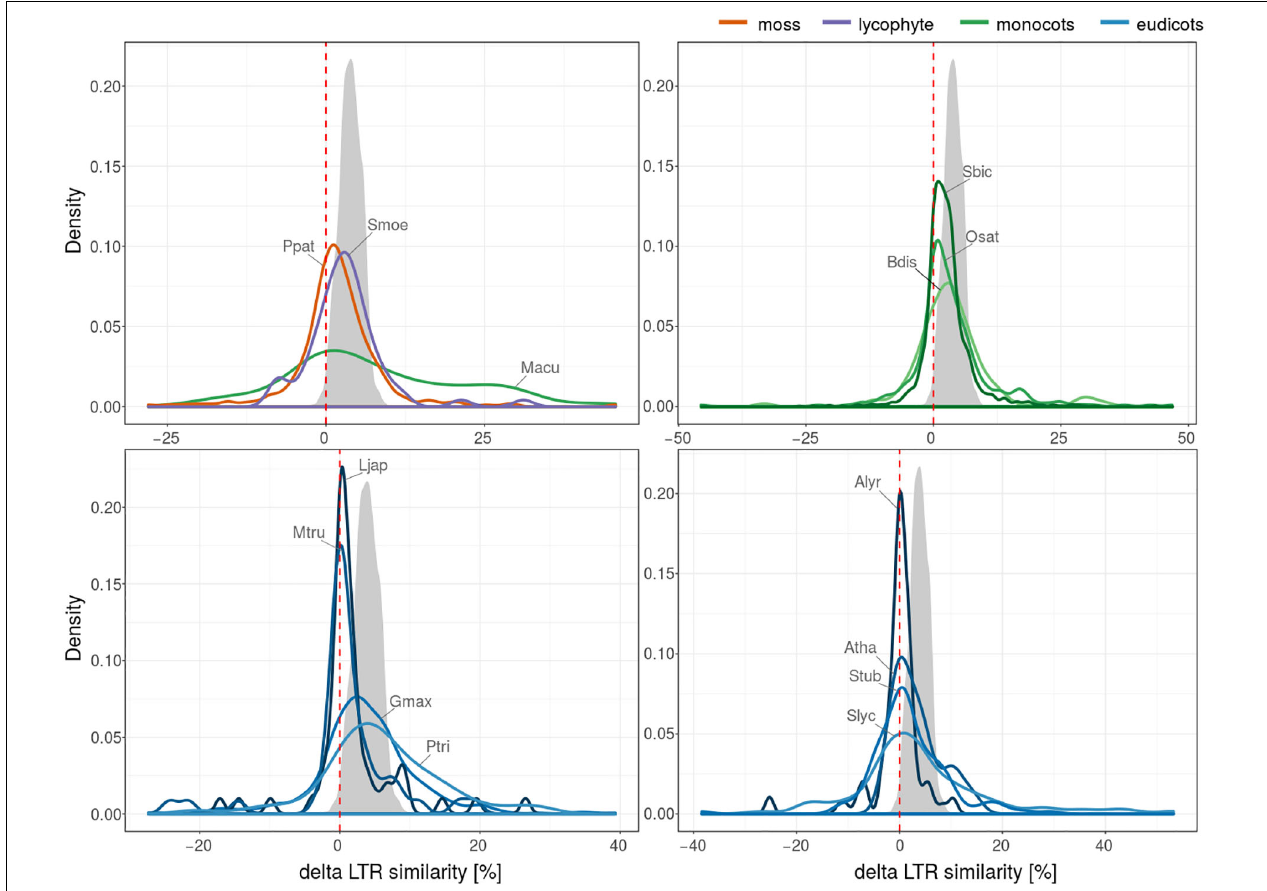
FIGURE 4 | 5 (cid:48) -3 (cid:48) LTR similarity in nested and original LTR retrotransposons. Plant species were divided into four subfigures for better readability. Plotted values represent probability density function based on kernel density estimation. Number of LTR retrotransposons with values of delta LTR similarity (positive values correspond to higher LTR similarity of nested than original elements) for LTR retrotransposons in studied plant species (4126 nested/original pairs). The gray area shows simulated delta LTR similarity distribution under the assumption that only randomly distributed point mutations affected a pair of nested LTRs inserted into another pair with 97% LTR similarity at the time of insertion. The simulated nested structure was then further mutated with mutate.sh at 10% of positions, on average and delta LTR similarity was calculated.